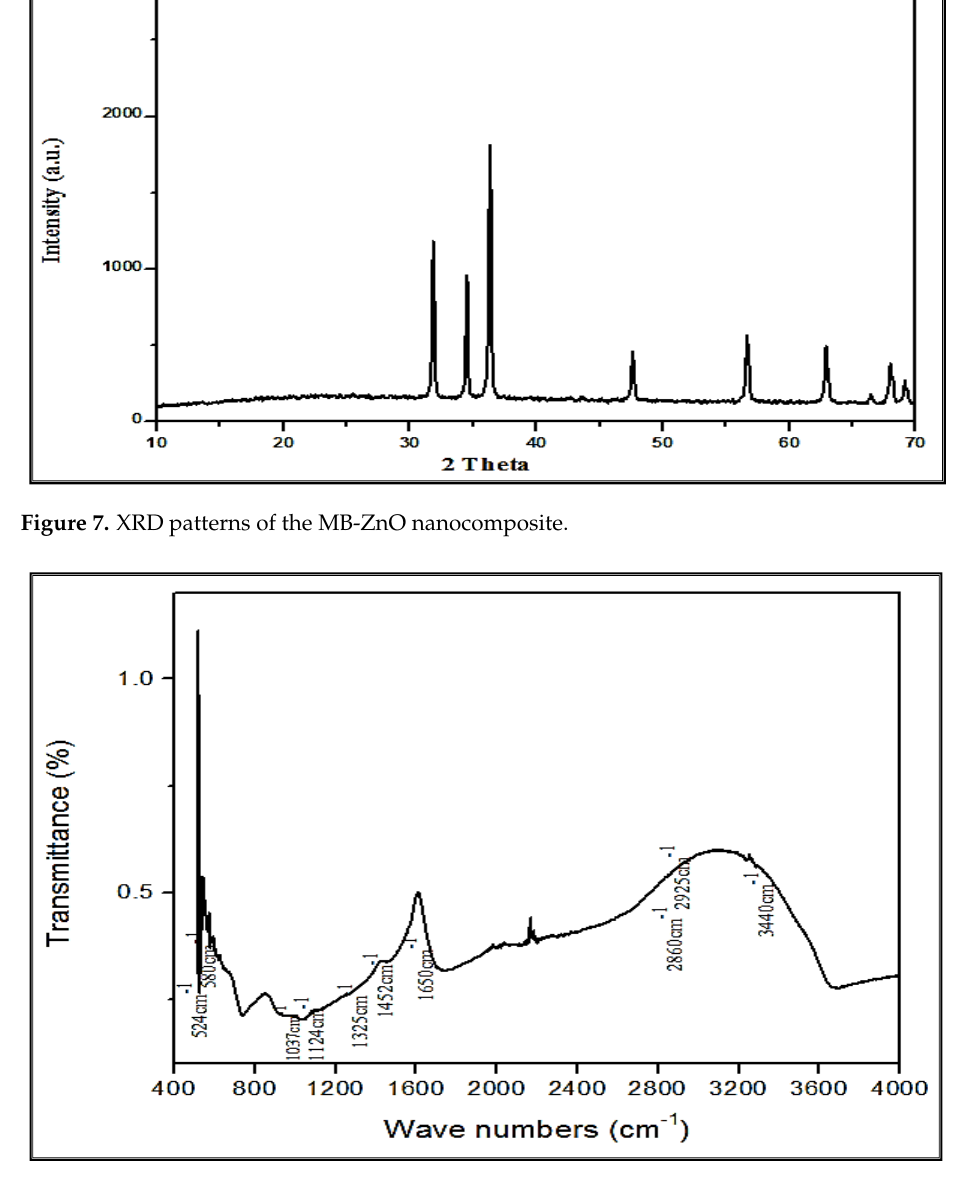
Figure 8. FTIR spectrum of the MB-ZnO nanocomposites.